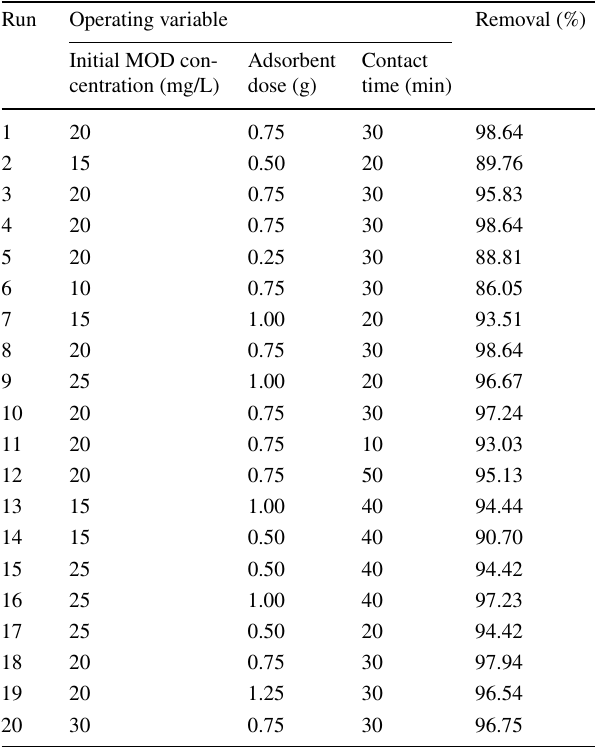
Table 4 Percent removal of MOD using